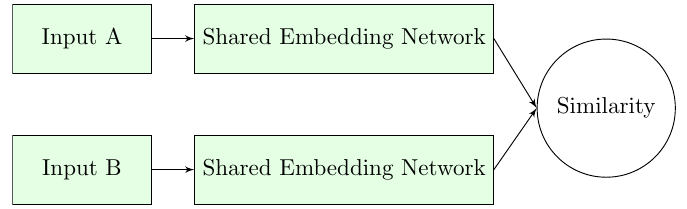
Figure 1. The architecture of the Siamese Neural Network. The underlying backbone network is shared, the output of the structure is a similarity